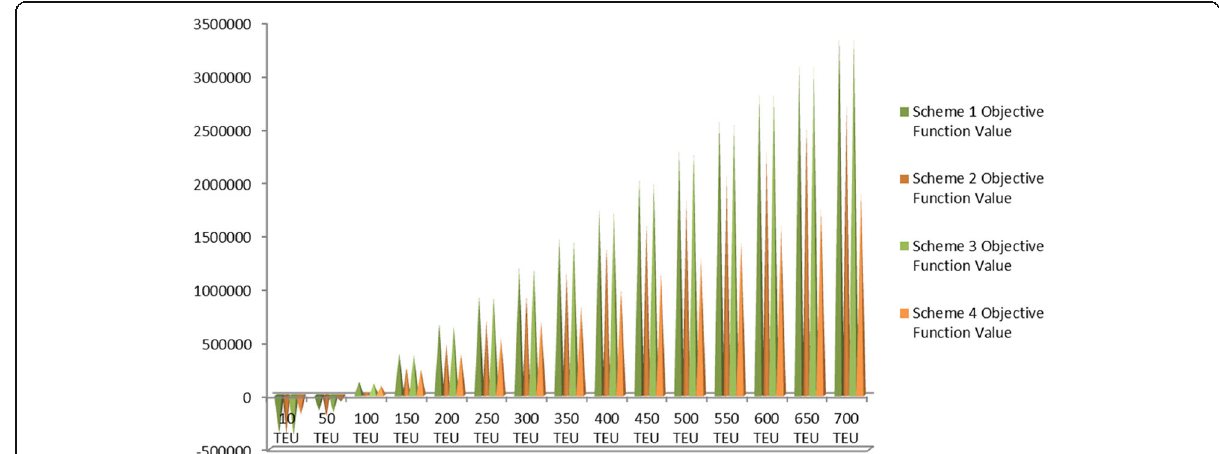
Fig. 2 Evaluation of Four Alternatives under Different Hypothesis of Intra-European Cargo (Source: authors)